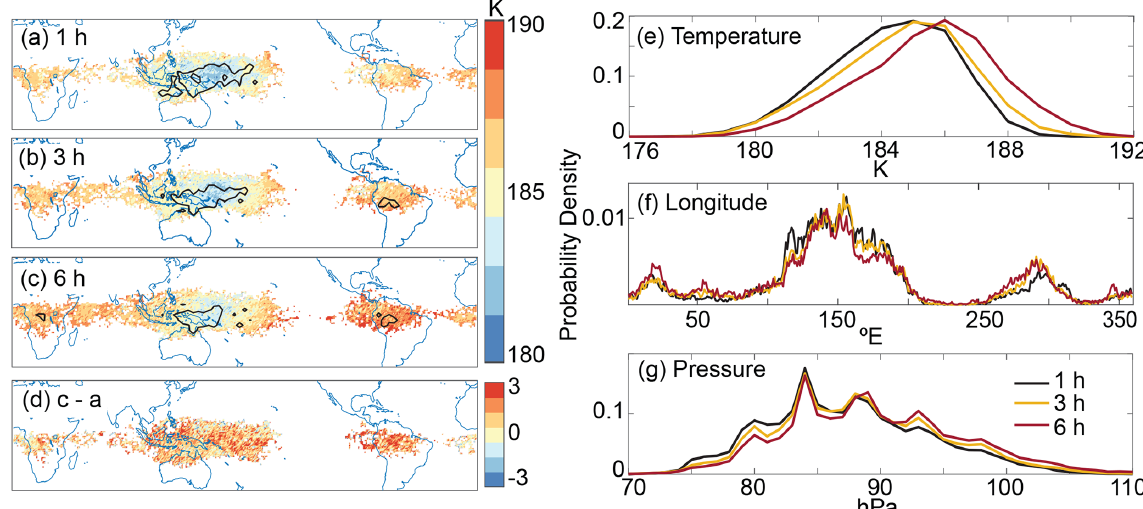
Figure 2. Panels (a–d) display the spatial distribution of the DJF 2017 trajectories’ cold point temperature for 1, 3, and 6h, and the difference in temperature between the 6 and 1h trajectories. Black contours in (a) , (b) , and (c) denote regions where the fraction of trajectories crossing grid cells is greater than 0.03%. Panels (e–g) display the probability density functions (PDFs) of the cold point temperature, longitude, and pressure for 1, 3, and 6h